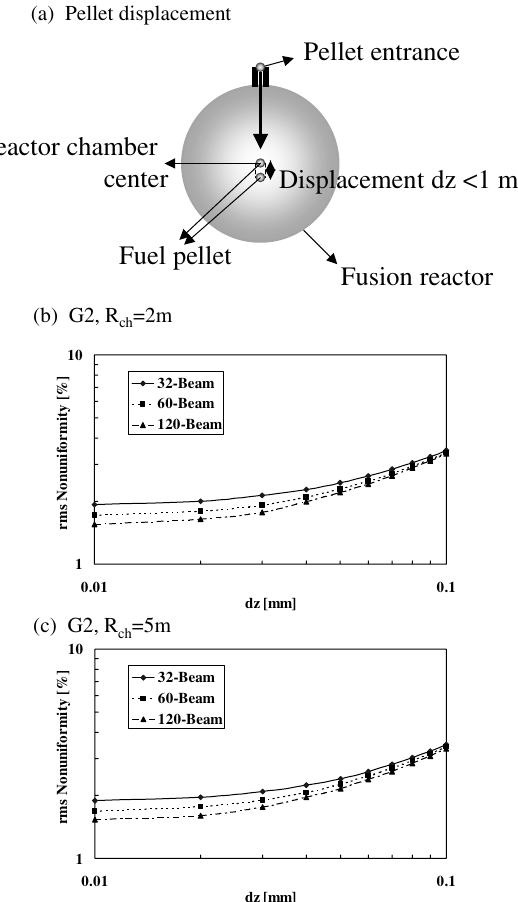
FIG. 16. (a) Pellet displacement from the chamber center. The pellet displacement versus the rms nonuniformity for the chamber radius of (b) 2 m and (c) 5 m in the cases of 32, 60, and 120-beam